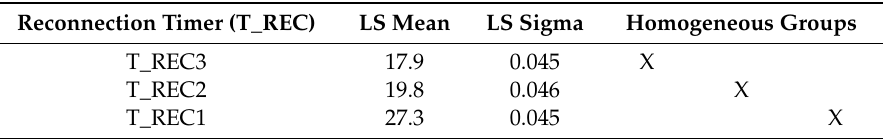
Table 4. Results of the Multiple Range Tests for the factor Reconnection Timer (T_REC), using as dependent variable the Number of control messages sent during the set-up time.